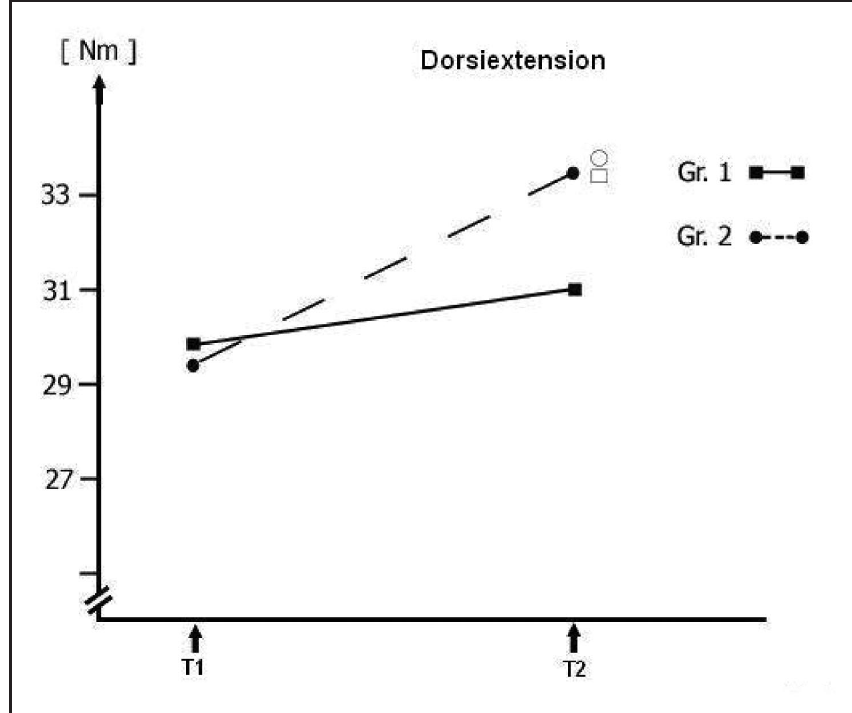
Figure 2: Maximum isokinetic torque in dorsi extension of the injured ankle in the comparison groups at the beginning of the investigation (T ) and at the end of the investigation (T 1 torque on the uninjured side).